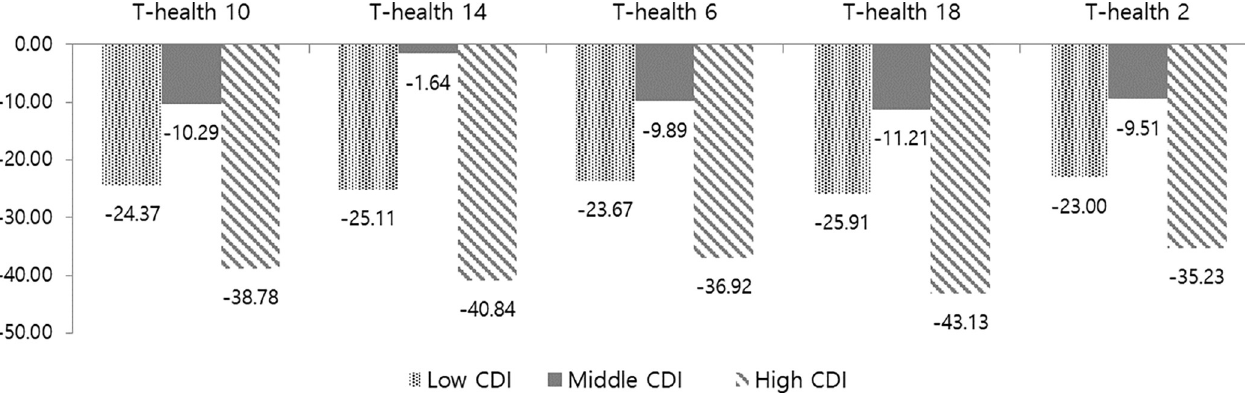
Fig 3. ICER of early dental visits according to regional deprivation